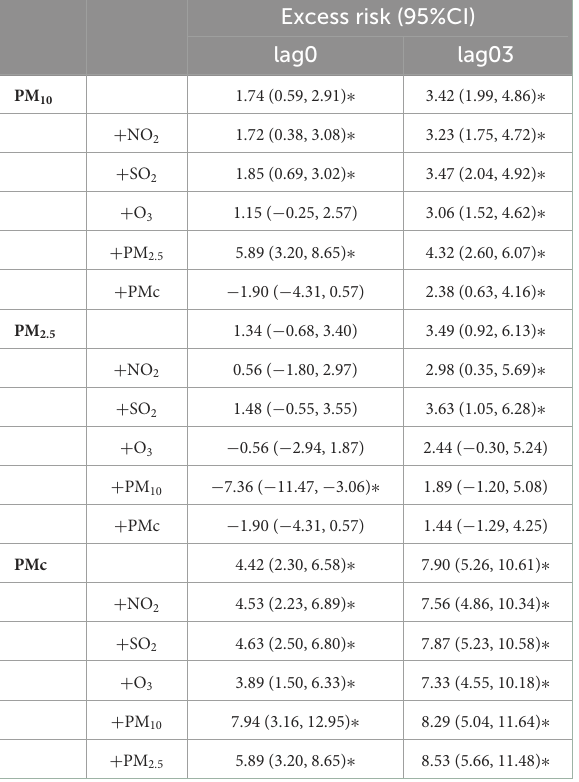
TABLE 4 Excess risk (%) and 95% CI of outpatient visits to fever clinics associated with each 10 µ g/m 3 increase in PM 10, PM 2.5 , and PMc (lag0, lag03) concentrations in single pollutant models and two-pollutant models,